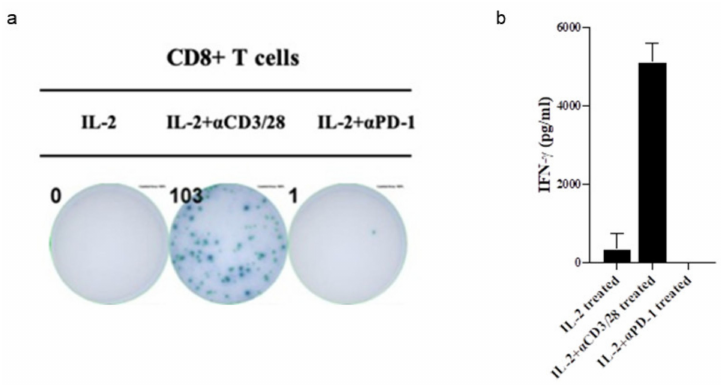
Figure 5. Significant increase of IFN-g secretion by anti-CD3/28 antibody treated CD8+ T cells. CD8+ T cells were sorted from PBMCs and treated with IL-2, the combination of IL-2 and anti-CD3/28 antibody (25 µ L/mL) or anti-PD-1 antibody (10 ng/mL) for 18 h before using in the ELISPOT ( a ) to determine the number of IFN-g secreting cells. Culture supernatants were collected for ELISA assays ( b ) to measure the concentrations of IFN-g secretion from treated CD8+ T